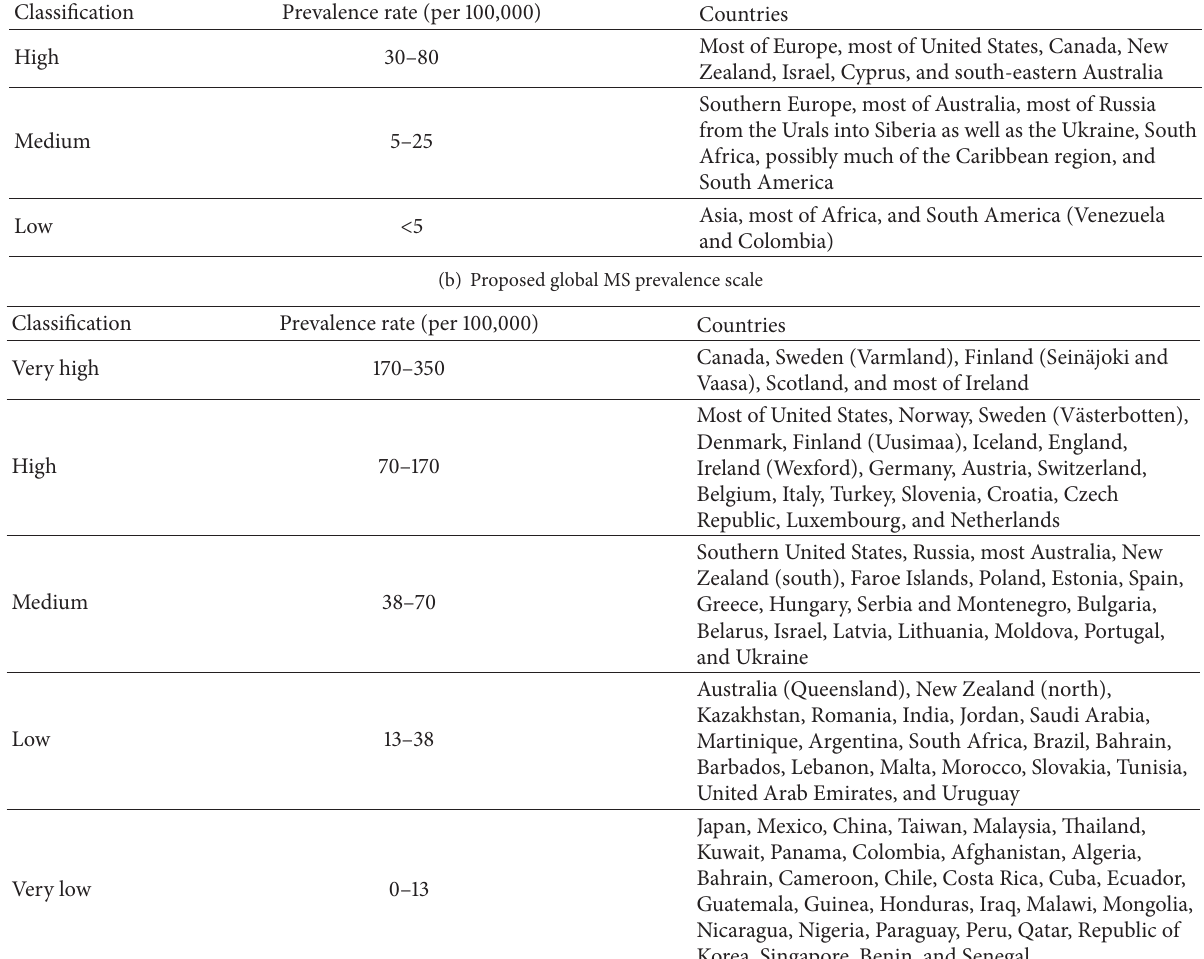
Table 4: Kurtzke’s versus proposed global MS prevalence